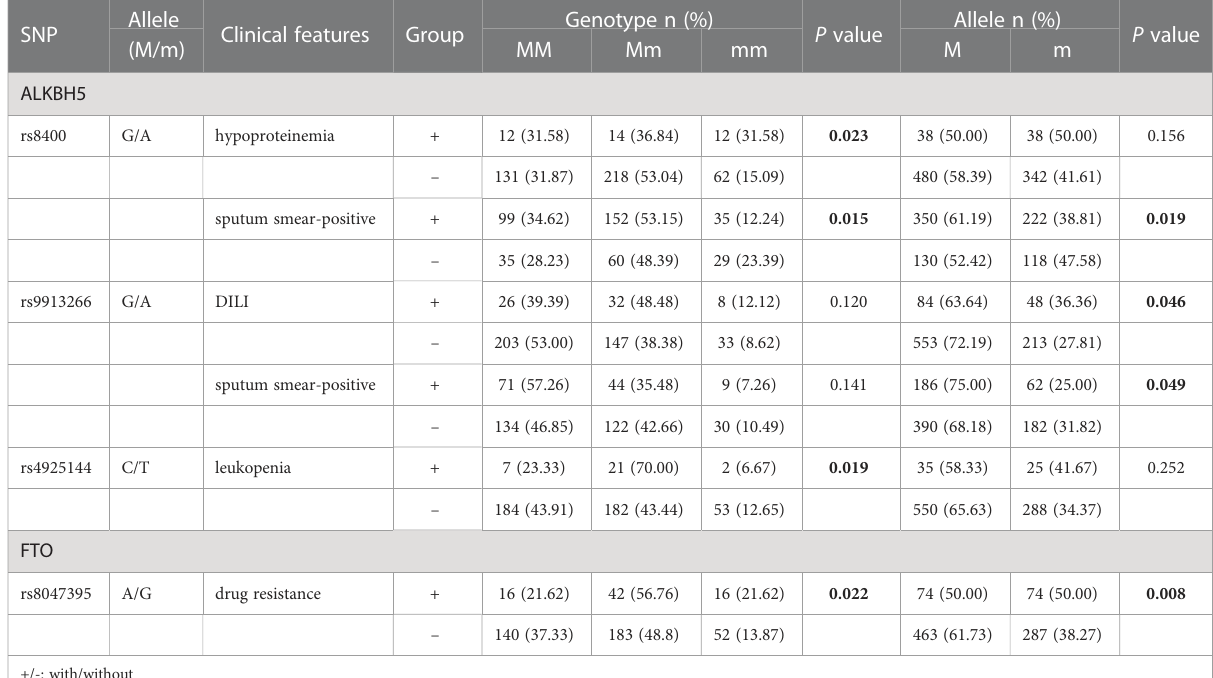
TABLE 1 The positive fi ndings of association between ALKBH5 , FTO gene polymorphism and some clinical manifestations in PTB patients. Allele SNP Clinical features